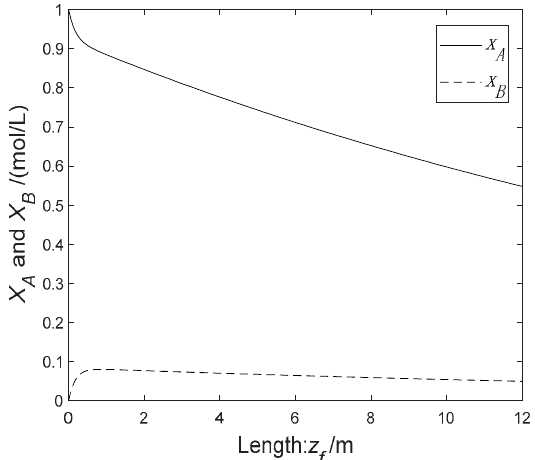
Figure 12. Optimal control trajectory (